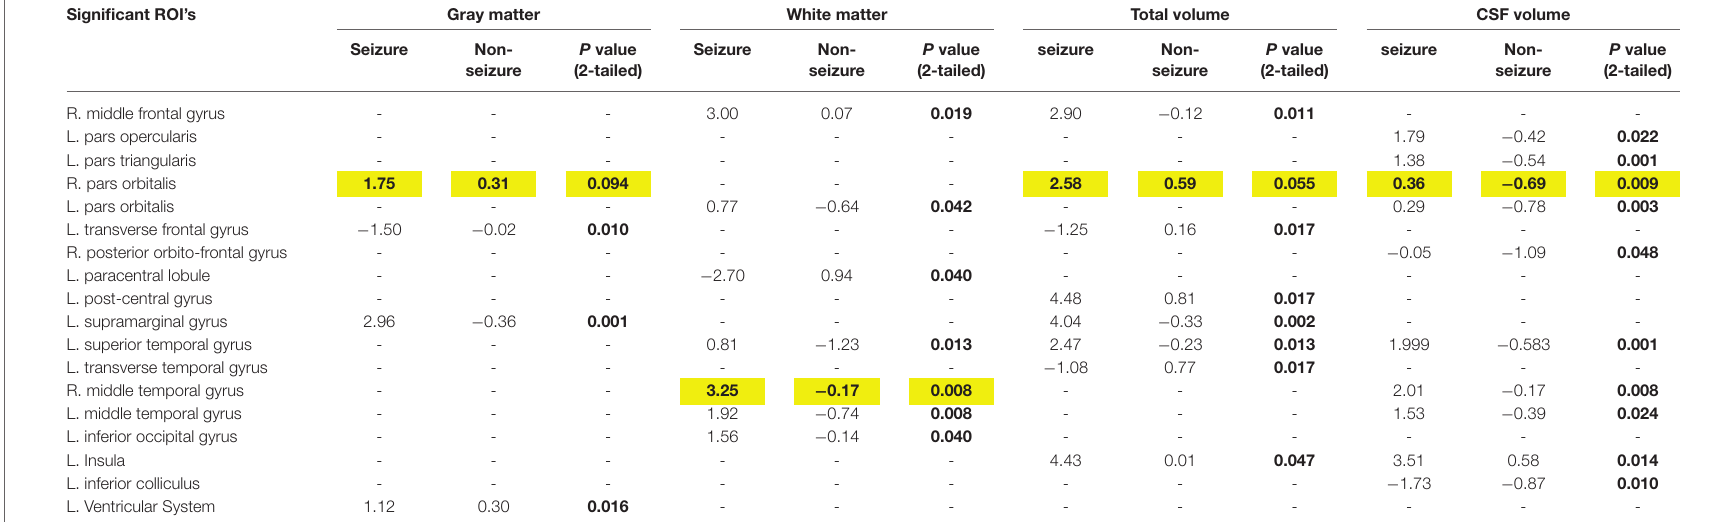
TABLE 2 | Significant differences in the mean z-scores in tumor patients with seizure vs. non-seizure across all volumetric COIs using two-tailed significance.